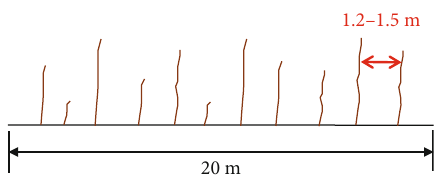
Figure 1: Simpli fi ed drawing of the natural fractures in Woodford shale.